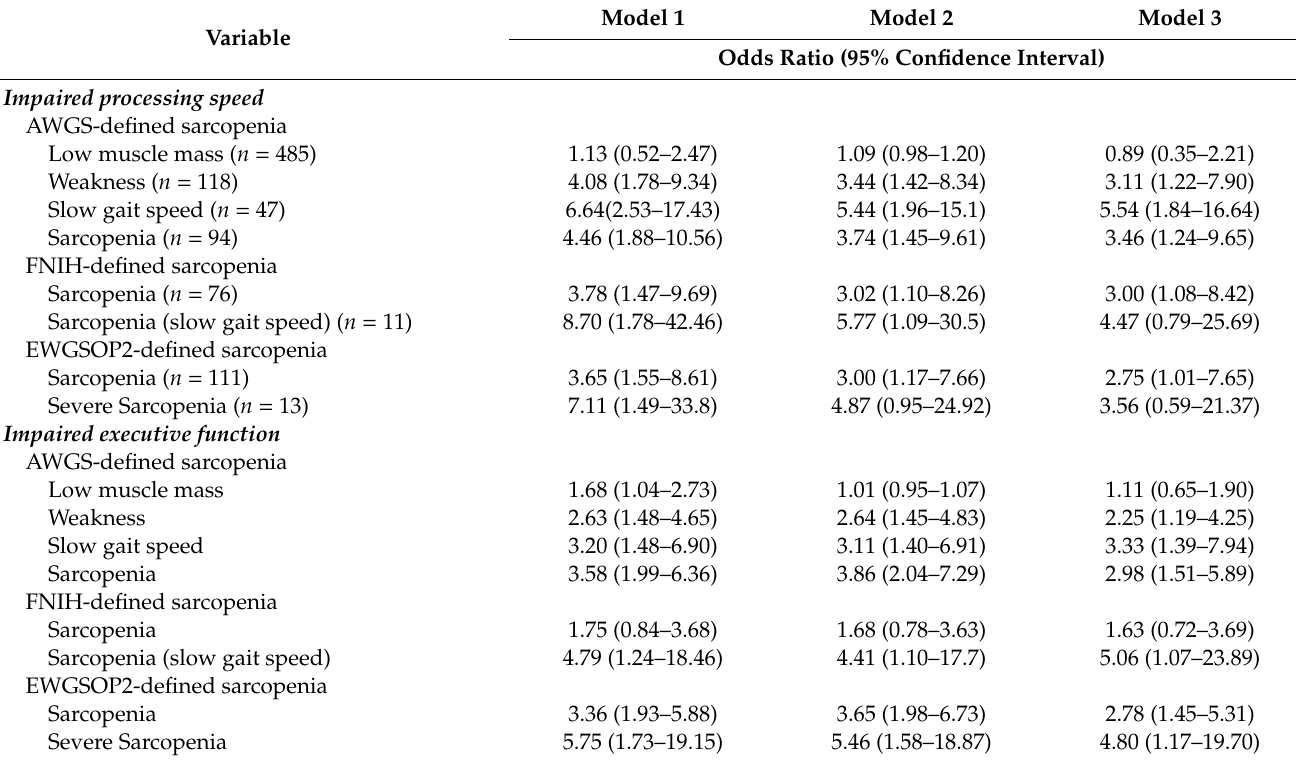
Table 3. Associations between sarcopenia and impairment of di ff erent cognitive domains in men ( n =